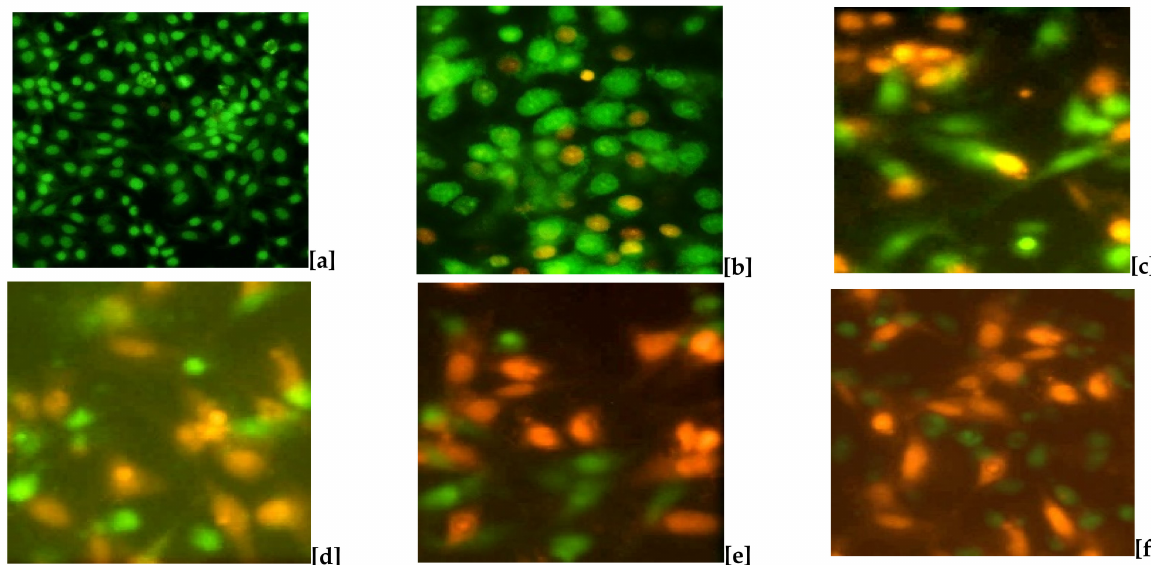
Figure 8. Apoptotic effect of Tyr-Cu(II)-AEEA NPs on MCF-7 cells. ( a ) Cell control, ( b ) 5 µ g/mL, ( c ) 25 µ g/mL, ( d ) 50 µ g/mL, ( e ) 75 µ g/mL, ( f ) 100 µ